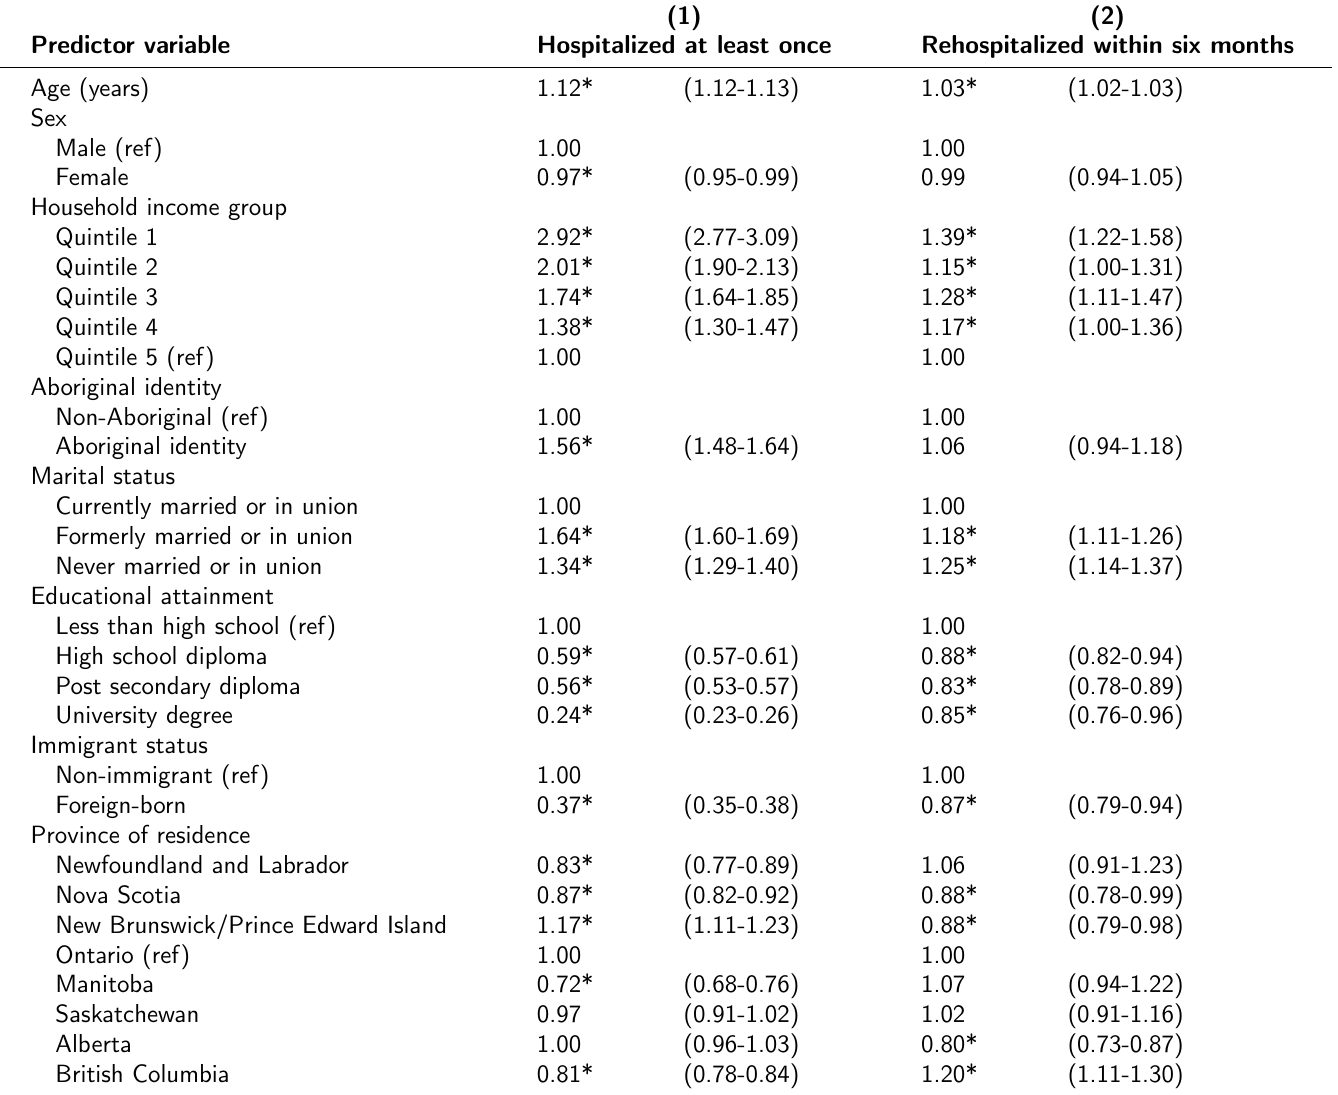
Table 1: Adjusted odds ratios (and 95% confidence intervals) for the risk of COPD hospitalization and six-month readmission among the population 30–69